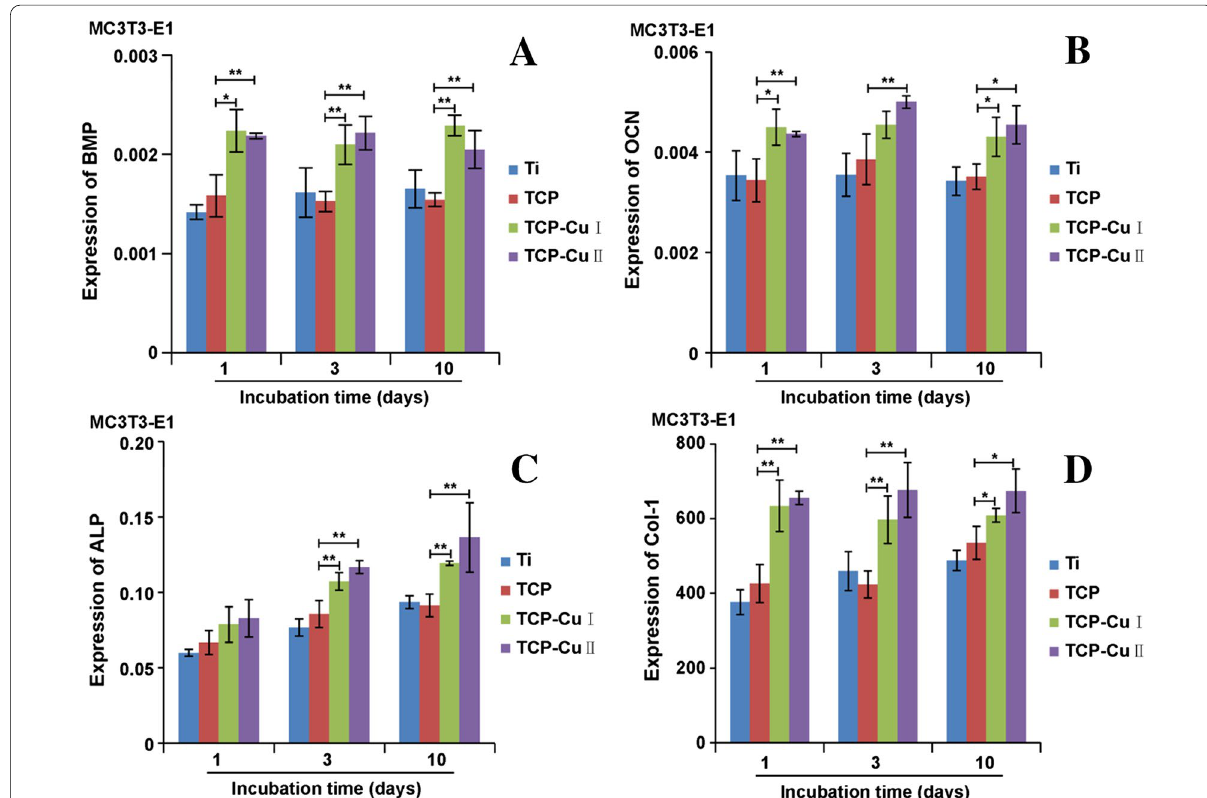
Fig. 9 The mRNA expression of BMP , OCN , ALP and COL-I after 1, 3 and 10 days of incubation (Data are presented as mean compared with group TCP, ** p < 0.01 compared with group